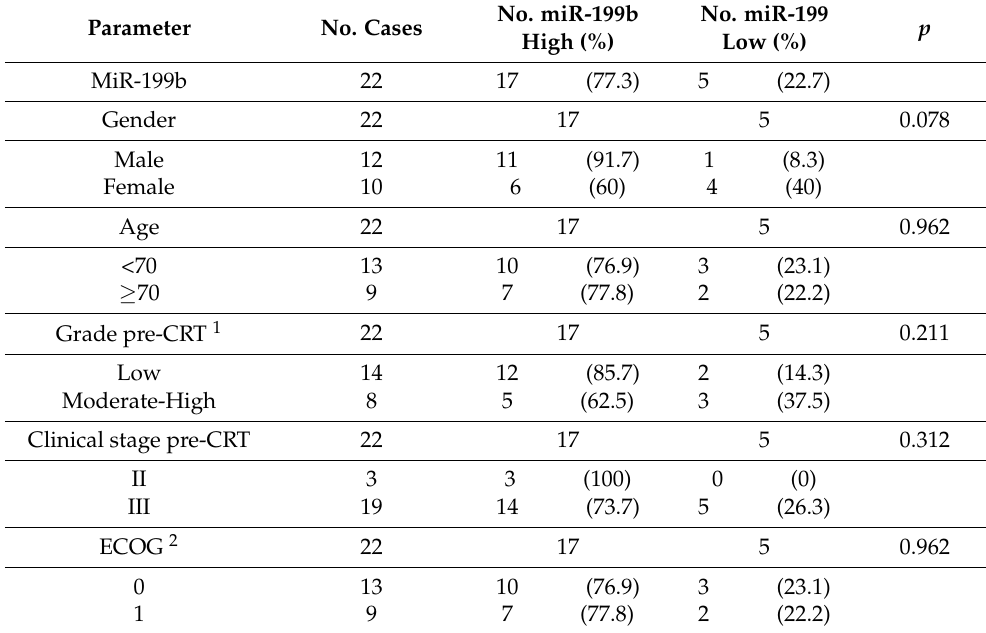
Table 1. Association of miR-199b expression with clinical and molecular characteristics in a cohort of 22 liquid biopsies from LARC patients.